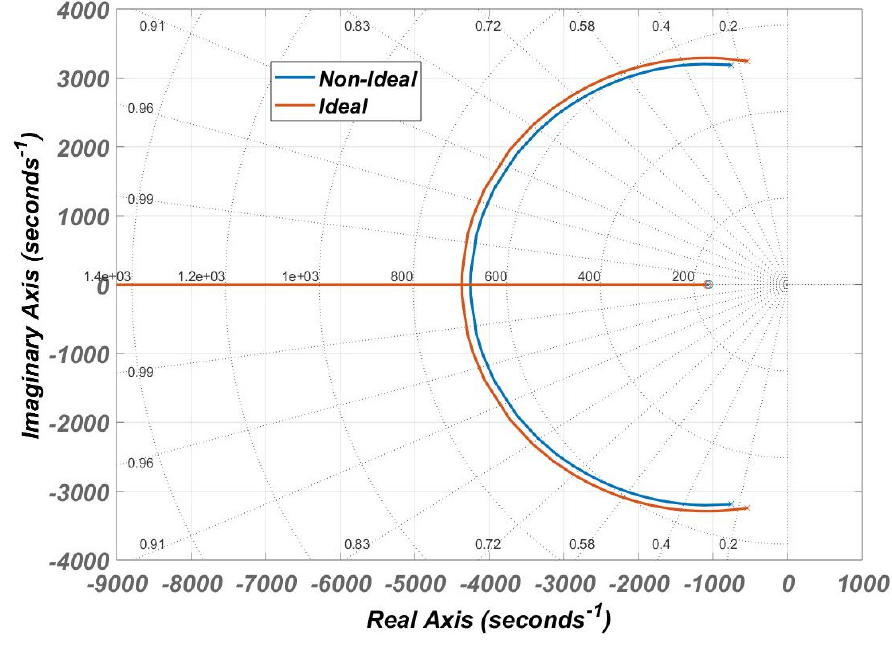
Figure 8. Root locus of G id for ideal and non-ideal buck converters.